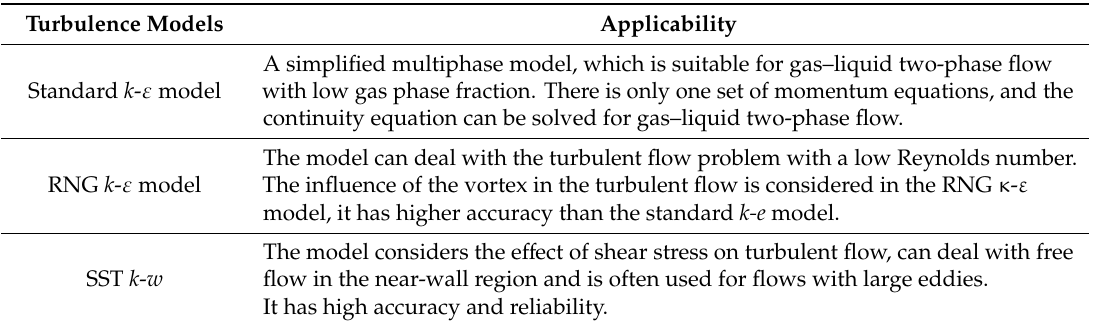
Table 6. The applicability of di ff erent turbulence models. SST: shear stress